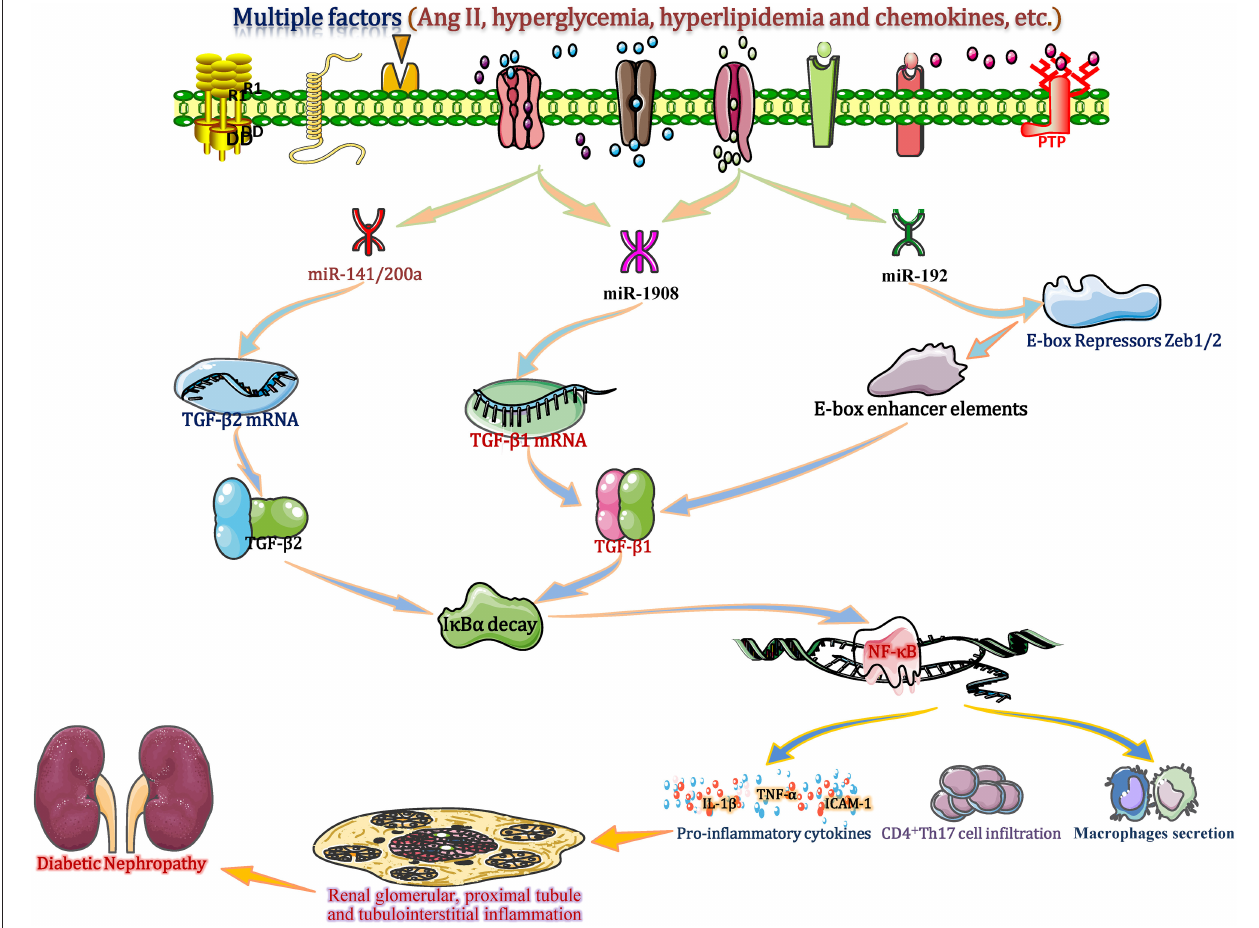
FIGURE 8 | miRNAs regulate TGF- β -related renal inflammation: crucial modulators of DN. Under diabetic conditions, hyperglycaemia, hyperlipidaemia and other factors, such as Ang II and chemokines, cause abnormal changes in several miRNAs, including the miR-1908, miR-192, and the miR-141/200a cluster in renal tissue and interstitial cells. miR-192 leads to increased TGF- β 1 expression in end-stage renal disease (ESRD) patients through downregulation of E-box repressor Zeb1/2. Other miRNAs (miR-1908 and miR-141/200a) increase the transcription and translation of the TGF- β 1/2 gene by reducing the binding with the 3 ′ -UTR of TGF- β 1/2 mRNA, leading to increased TGF- β 1/2 expression. TGF- β largely accelerates the decay of I κ B α mRNA to promote activation of NF- κ B (p50/p65 subunit), which enters the nucleus and induces gene transcription. Then, activated NF- κ B increases the accumulation of IL-1 β , ICAM-1, and TNF- α and induces glomerular macrophage secretion and CD4 + Th17T cell infiltration in glomerular and tubulointerstitial tissues, eventually promoting renal glomerular, proximal tubule, and tubulointerstitial inflammation and DN progression. ICAM-1, intercellular adhesion molecule-1; IL-18, interleukin 18; TGF- β , transforming growth factor- β ; Th17 cell, T helper cell 17; TNF- α , tumor necrosis factor- α ; Zeb1/2, zinc-finger E-box binding homeobox